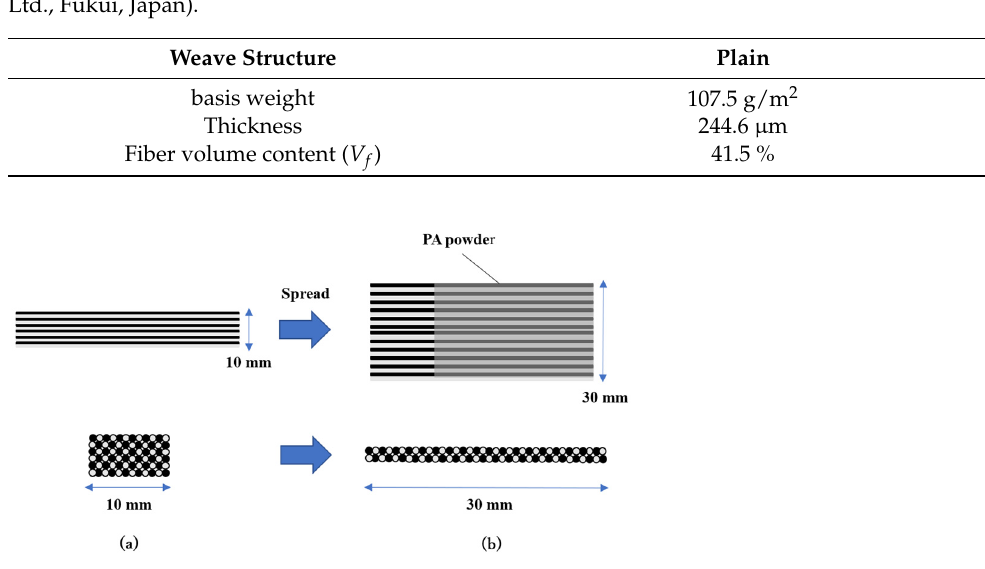
Table 2. Specifications of woven fabric using commingled yarn (Manufacture; Harmoni Industry Co. Ltd., Fukui, Japan) .